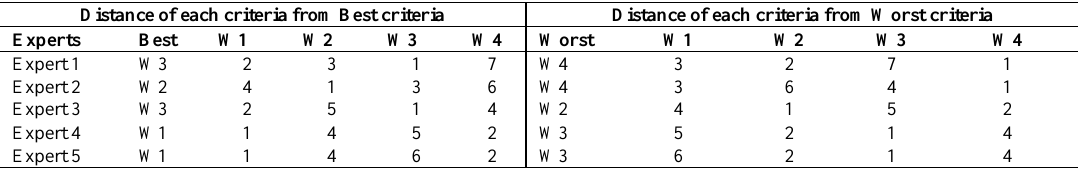
Table 3. Preference of best and worst criteria over other criteria using scale 1 to